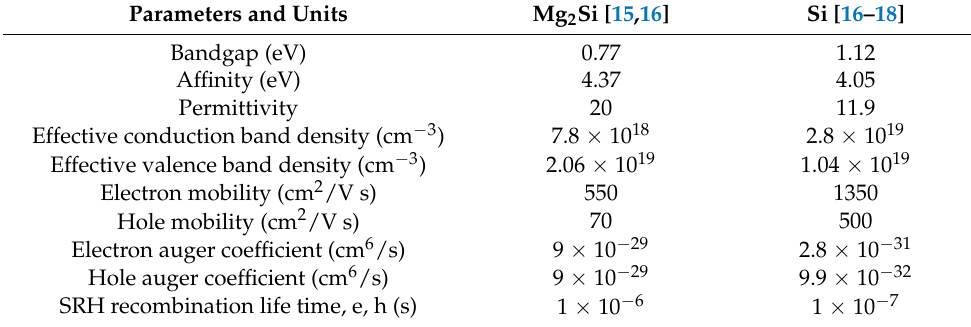
Figure 1. The schematic diagram of the Mg 2 Si/Si heterojunction PD.